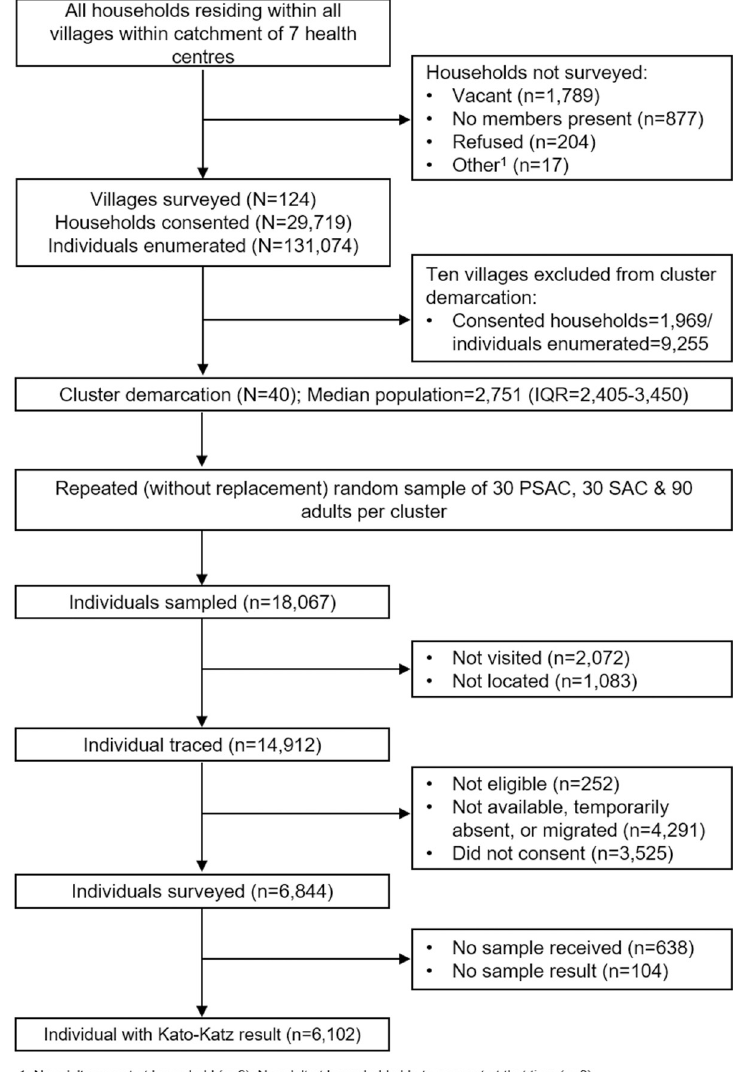
Fig 2. Study participant flow